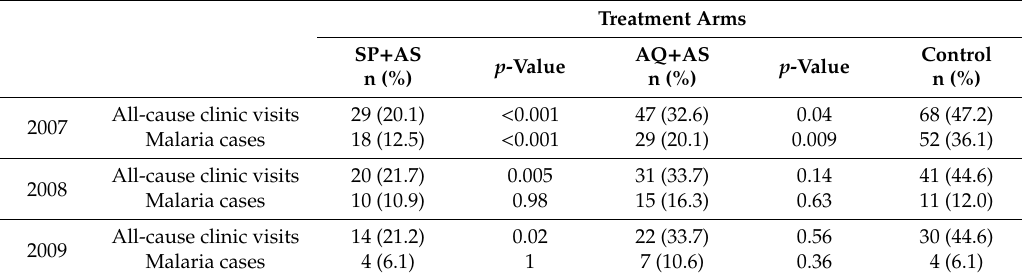
Table 2. Unscheduled Visits and Malaria